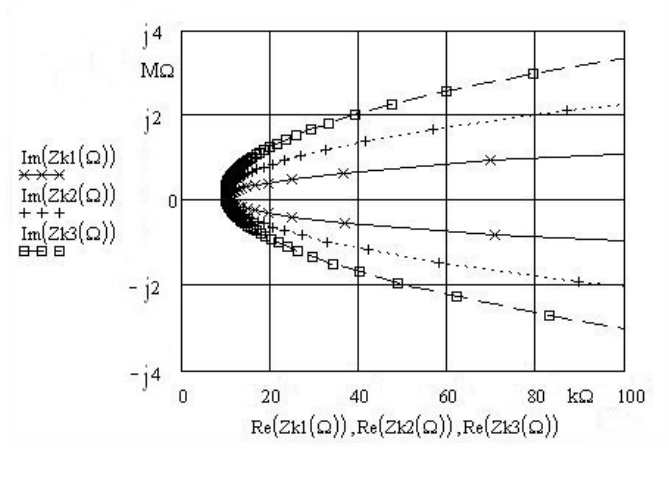
) for different k = 1, 2, 3 ( Ω = 0.998, o